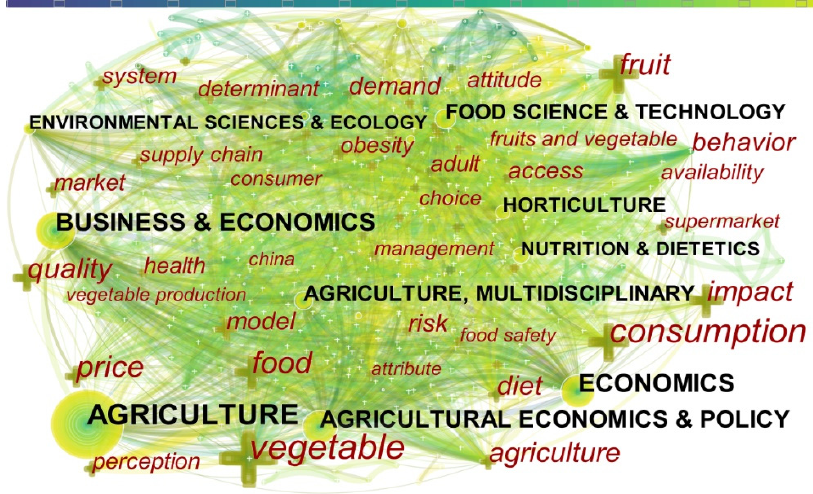
Figure 4. WOS Keyword Co-occurrence Network Diagram.